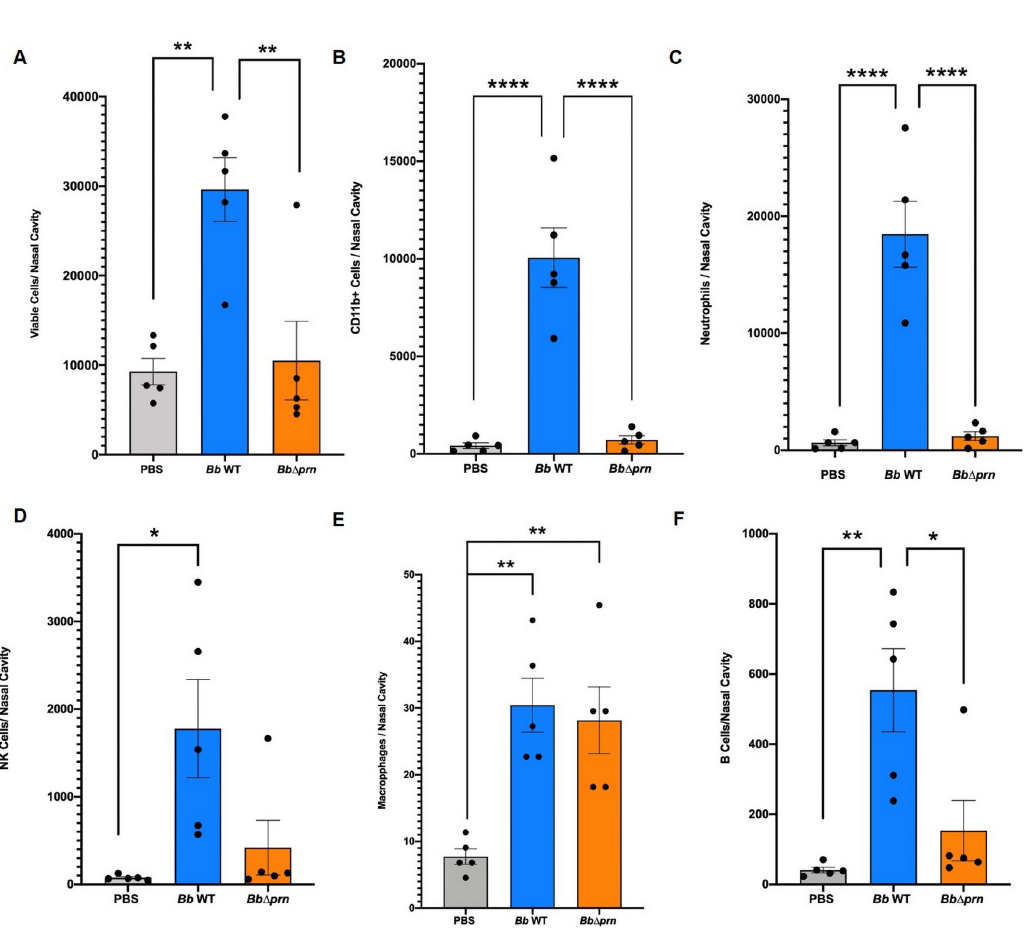
Fig 4. B . bronchiseptica PRN contributes to the recruitment of leukocytes, neutrophils and B cells in the nasal cavity. A) Total cells recruited in nasal cavities. B) Comparison of CD11b+ cells recruited in nasal cavities. C) Neutrophils recruited in nasal cavities. D) NK cells recruited in nasal cavities. E) Macrophages recruited in nasal cavities. F) B cells recruited in nasal cavities. There were 5 mice in each time point per group. Error bar shows the standard error of mean. Statistical significance was calculated using One-way ANOVA. � p < 0.05, �� p < 0.01, ��� p < 0.001, ���� p < 0.0001.